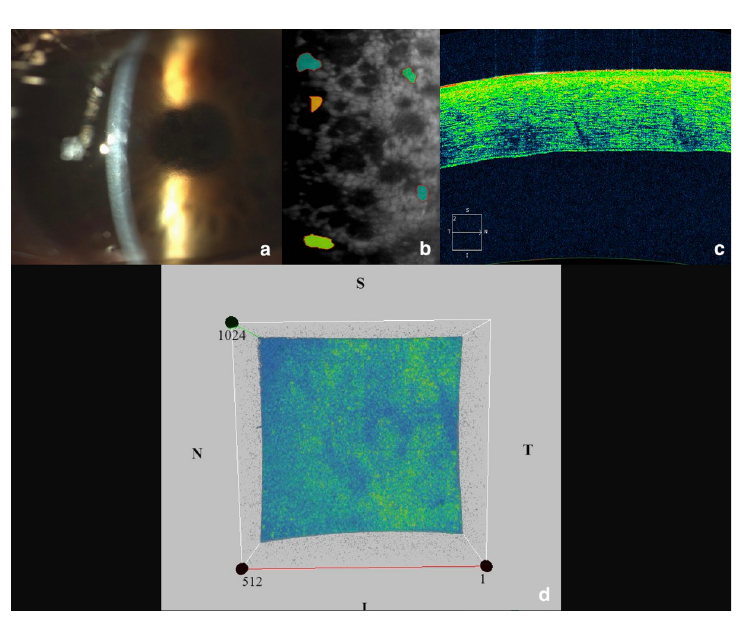
Fig 3. The study eye of a patient with severe FECD and its related OCT pattern n. 3 (‘marmoreal’ appearance). (a) slit-lamp biomicroscopy showing important alterations of the cornea including the presence of endothelial guttae and full-thickness edematous opacities; (b) specular endothelial microscopy confirming the advanced stage of the disease with few residual endothelial cells; (c) cross-sectional AS-OCT scan disclosing irregularities of all corneal layers with a non-homogeneous reflectivity; (d) 3D AS-OCT image of a 512x128 cube scan showing a mottled appearance of the inner corneal surface with a variable number of hyper-reflective areas, resembling a marmoreal look-like.